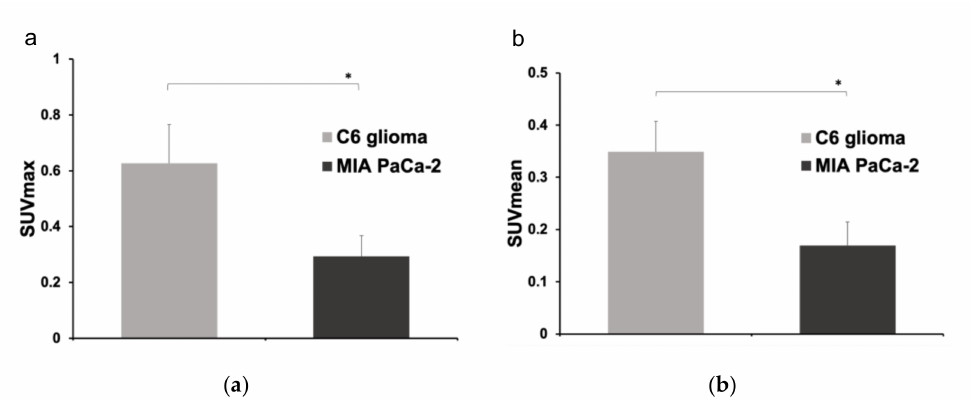
Figure 3. Comparison of ( a ) the maximum standardized uptake value (SUV max ) and ( b ) the SUV mean between the C6 glioma ( n = 6) and MIA PaCa-2 ( n = 6) mouse models (*: p < 0.05 as determine by an unpaired t -test).